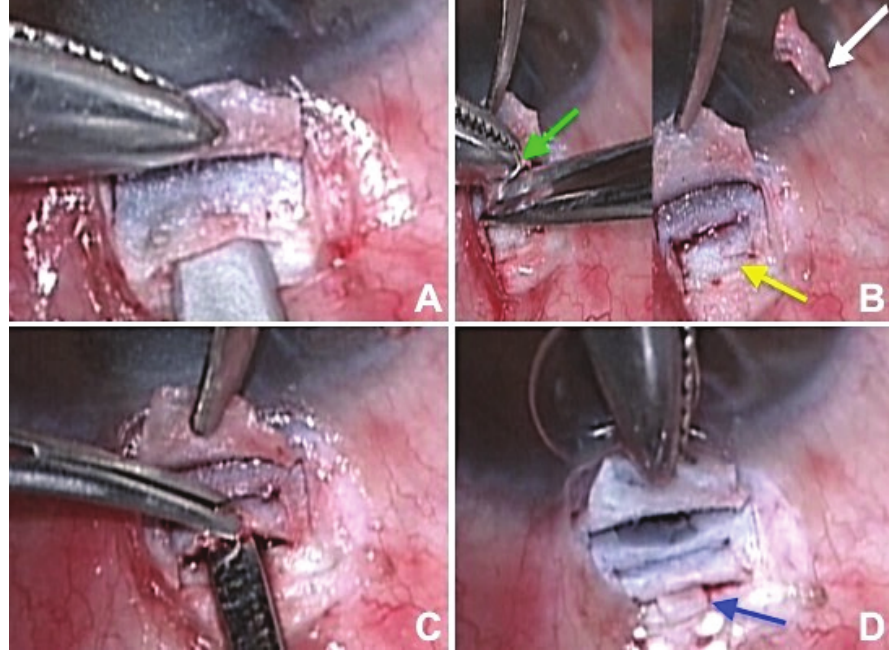
Figure 1. (A) Intraoperative image showing the creation of deep crater after making partial thickness scleral flap. (B) Dissection of the scleral block with Vanna’s scissor (green arrow) and creating a deeper crater (yellow arrow), scleral block after dissection (white arrow). (C) Full-thickness incision made for cyclodialysis and cleft is created by using cyclodialysis spatula. (D) Scleral block is inserted in the cyclodialysis cleft (blue arrow).